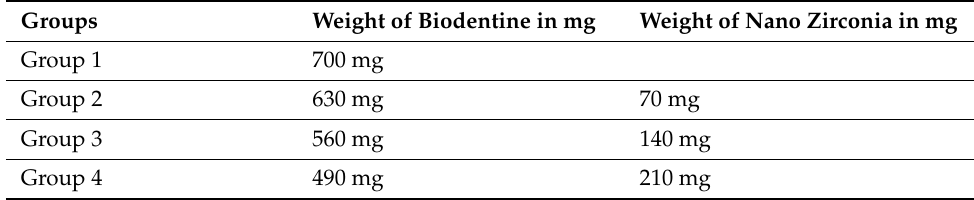
Table 1. Weight proportion of Biodentine and nano zirconia in all